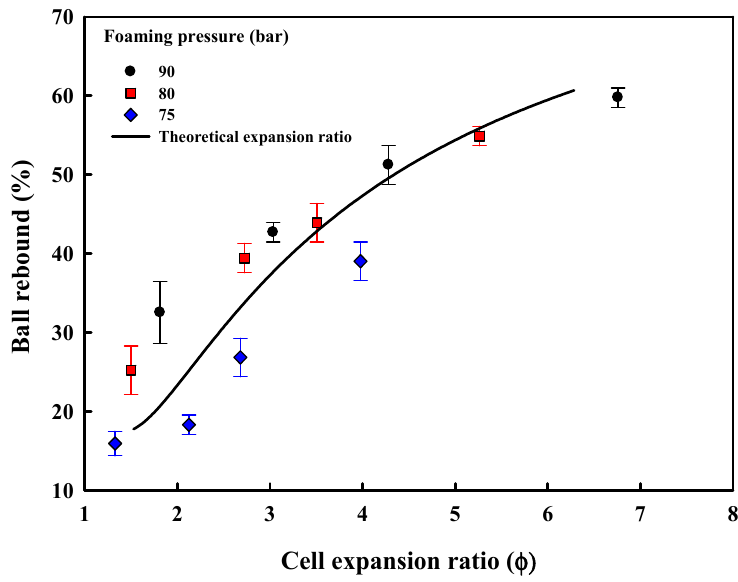
Figure 9. Effect of foam structure on the ball rebound of ETPU foam sheets.